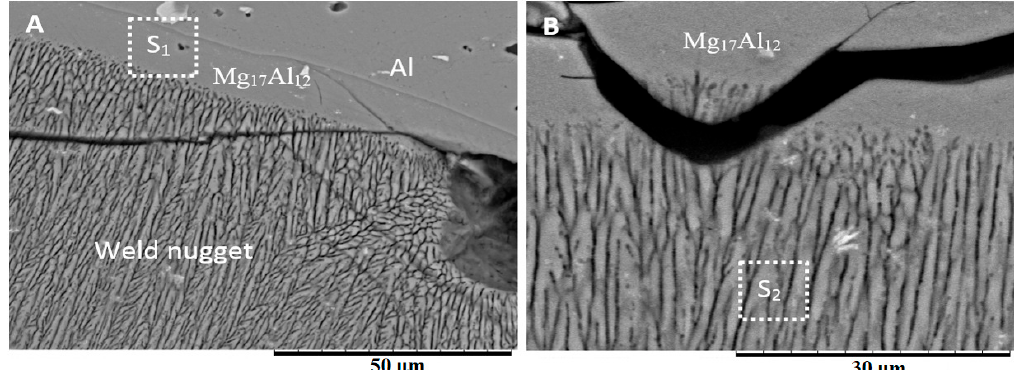
Figure 4. ( A ) Microstructure at the Al weld interface; ( B ) Detailed microstructure of the planar interface at the Al fusion interface.